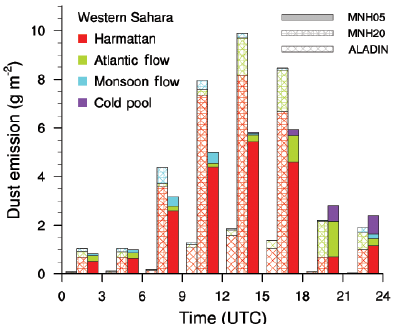
Figure 8. Diurnal cycle of dust emission in June 2011 from AL- ADIN, MNH20 and MNH05 over the western Sahara, the area of interest shown in Fig. 6.